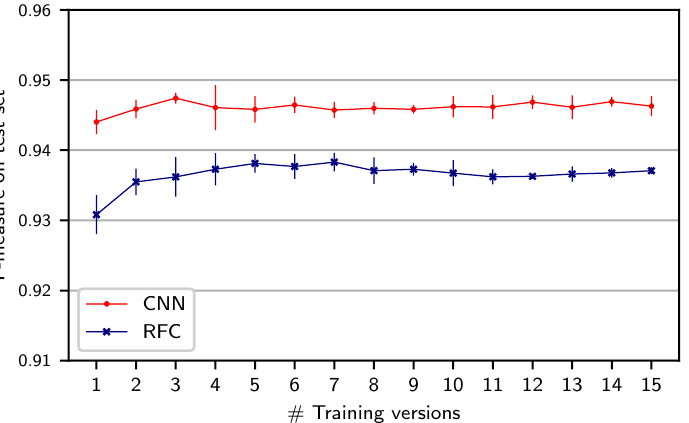
Figure 5. Results for both systems when training on varying numbers of versions of an act (B2) that is different from the test act ( neither split